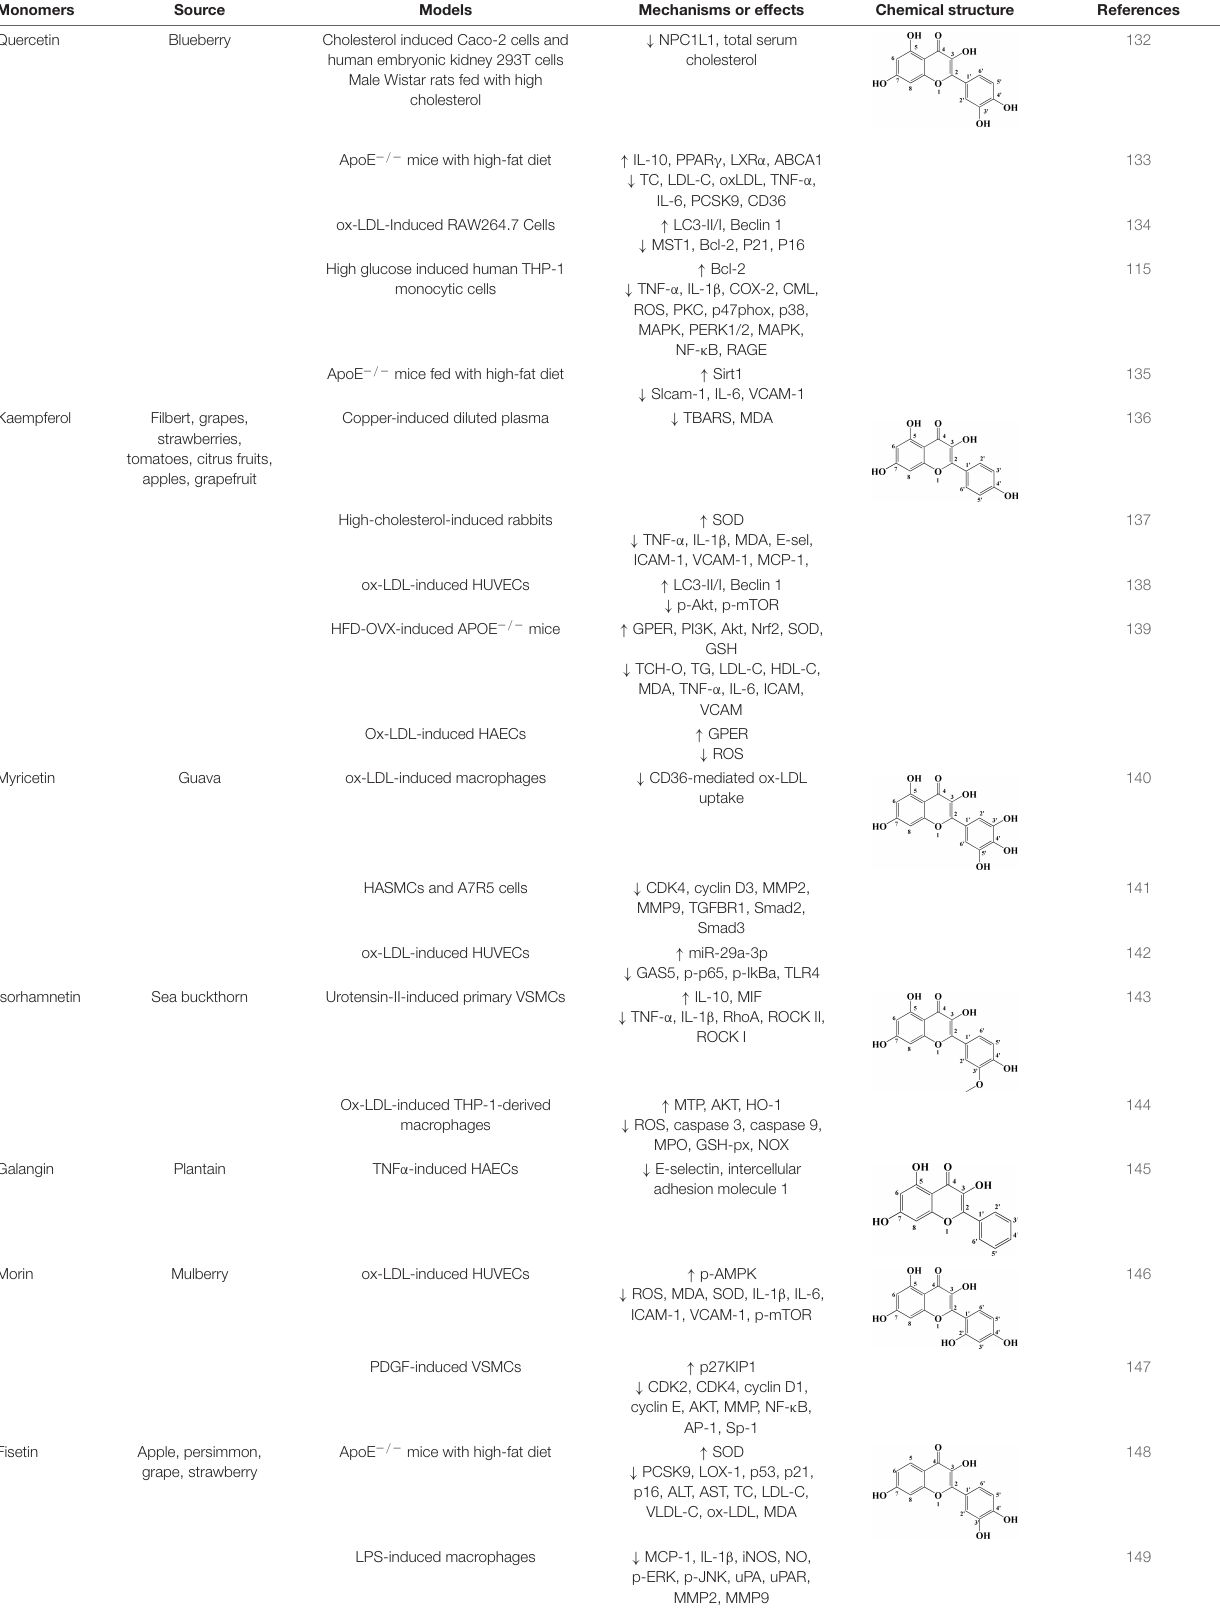
TABLE 1 | Flavonols derived from fruits are potential agents against